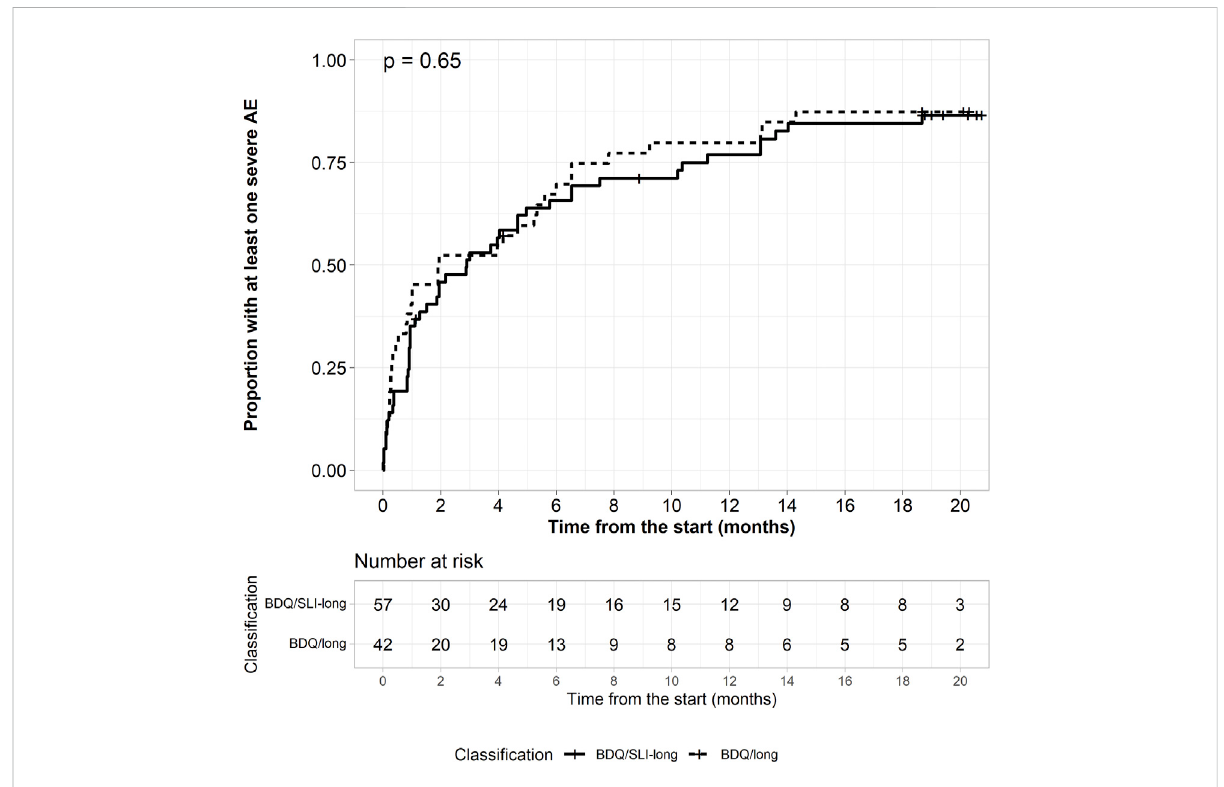
FIGURE 2 Kaplan-Meier plot for time to the fi rst severe adverse